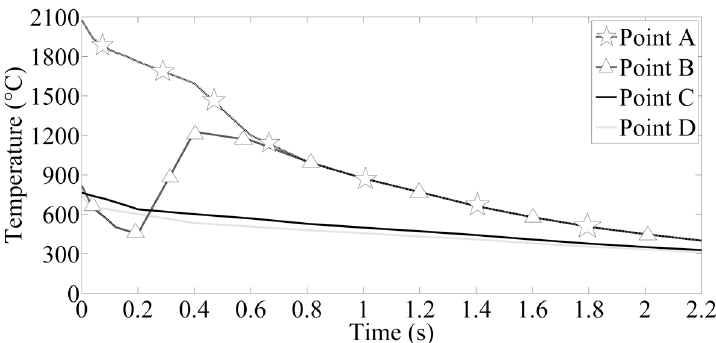
Figure 13. Temperature profile of the four points after the welding current was cut off.